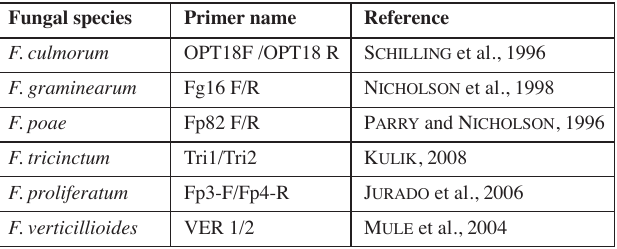
Tab. 1: Primers used for species-specific quantification of Fusarium DNA Fungal